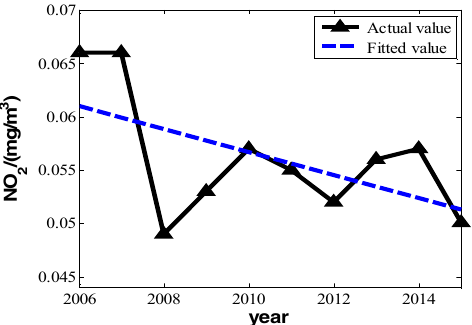
Picture 3. The change of nitrogen dioxide’s annual daily mean in 2006 to 2015. Figure 3. The change of nitrogen dioxide’s annual daily mean in 2006 to 2015. Int. J. Environ. Res. Public Health 2018 , 15 , x 8 of 15